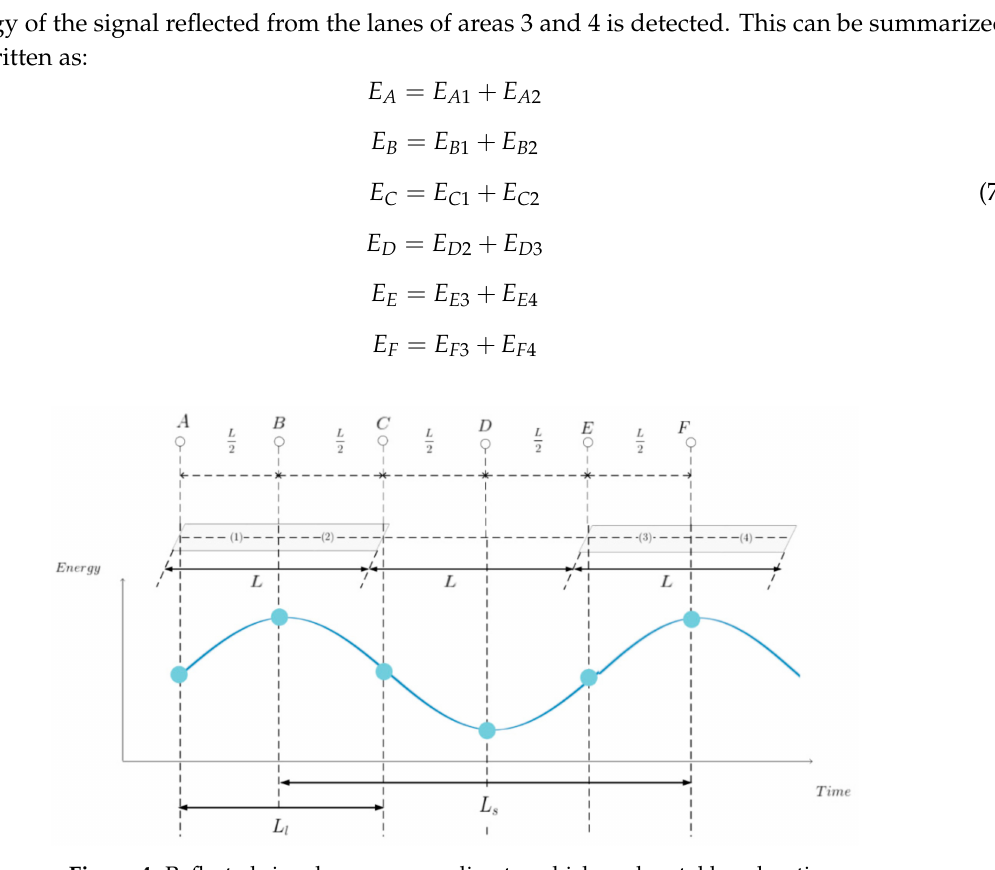
Figure 4. Reflected signal energy according to vehicle and metal lane